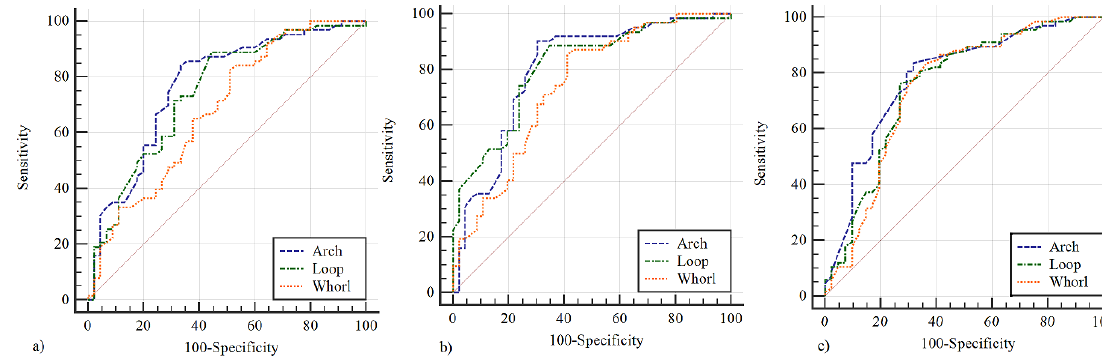
Figure 12. Analysis ROC of the CNN ( a ), Support Vector Machine ( b ), Random Forest ( c